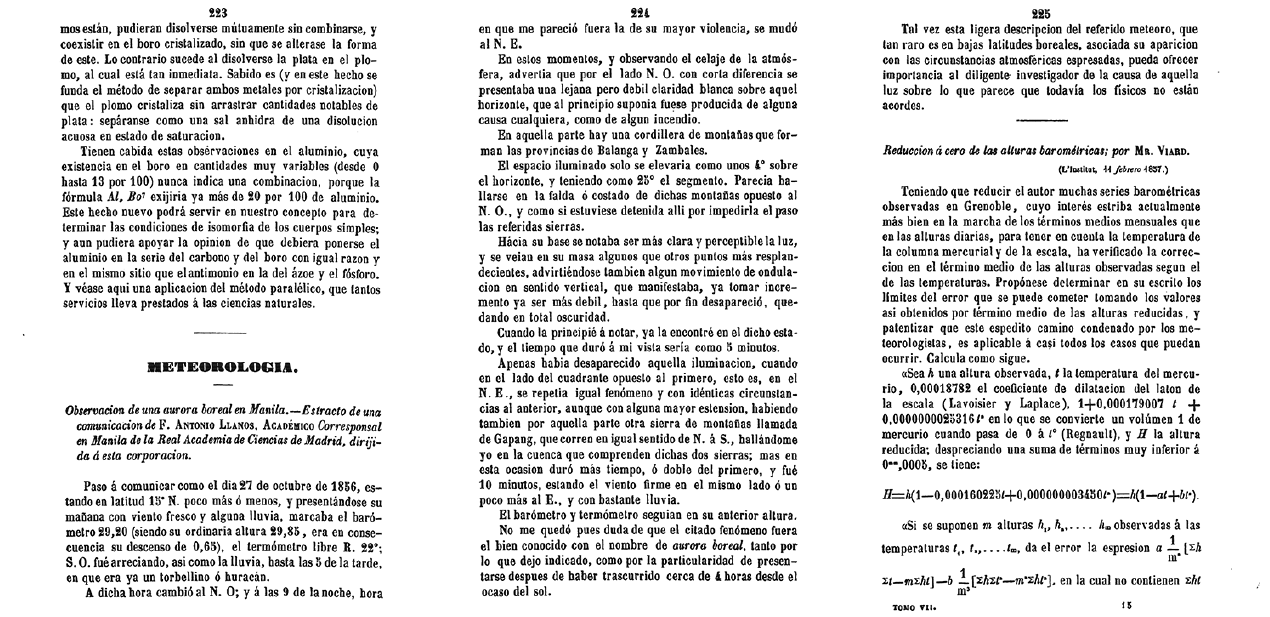
Figure 1. The original report in Spanish by Llanos